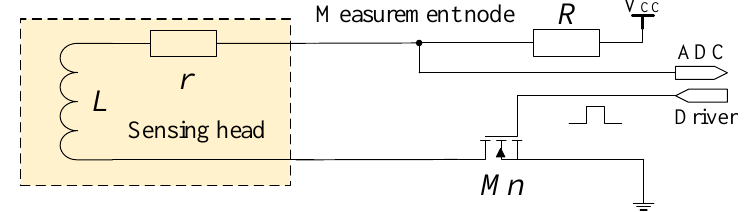
Figure 4. Driving and sampling of the integrative